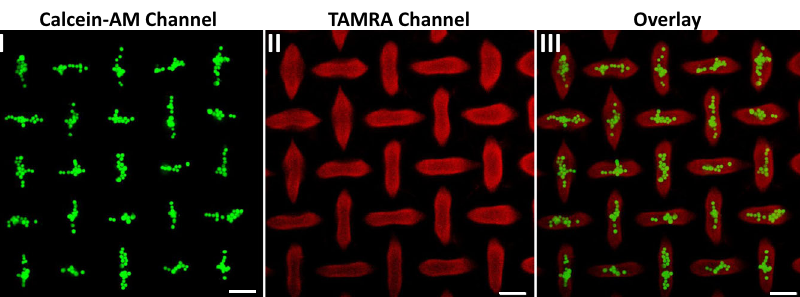
Fig. 8 Confocal microscope images of HeLa cells bound and proliferated in con fi ned ellipsoid microstructures formed upon the HCR-induced process in the continuous hydrogel fi lm. Panel I — Fluorescence microcopy image (Calcein-AM channel) of the calcein-AM stained HeLa cells proliferated in the ellipsoid microstructures. Panel II — Fluorescence microcopy image (TAMRA channel) of the ellipsoid microstructures modi fi ed with MUC-1 aptamer. Panel III — Overlay of panel I and panel II. Scale bars correspond to 50 μ m. N = 3 independent experiments